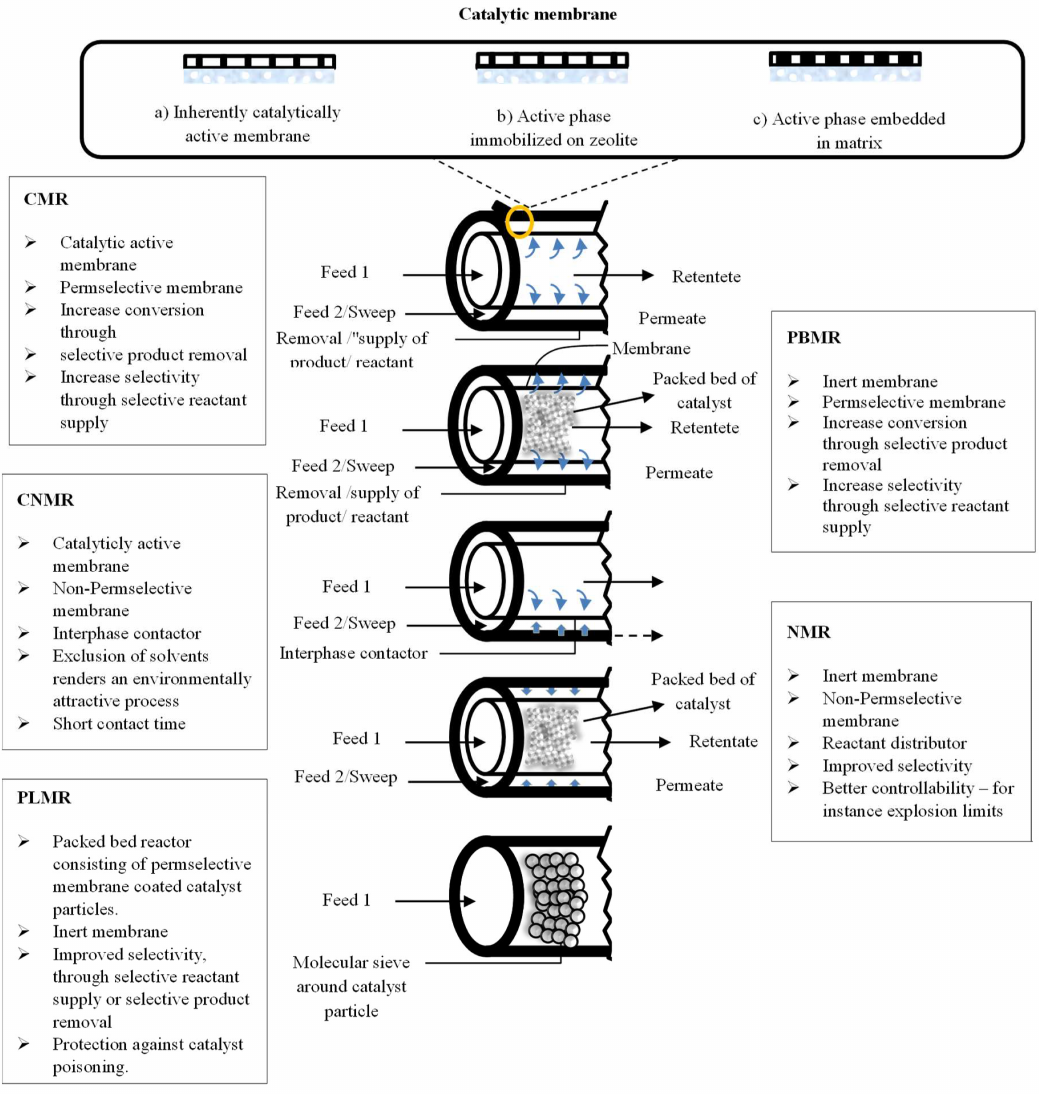
Figure 5. Scheme of a MR operated in flat configuration: (I) Product removal to overcome thermodynamic limitation; (II) selective removal of a desired product; (III) controlled addition of a reactant for selective permeation.